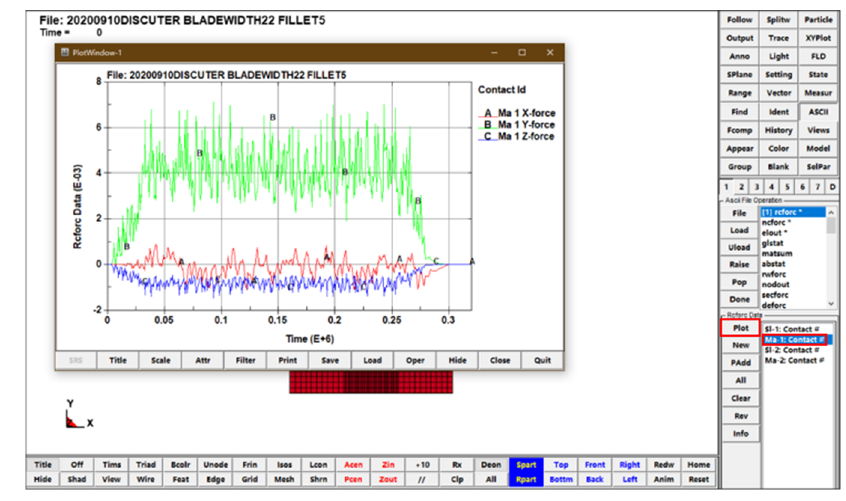
Figure 13. Load RCFORCE into the model.